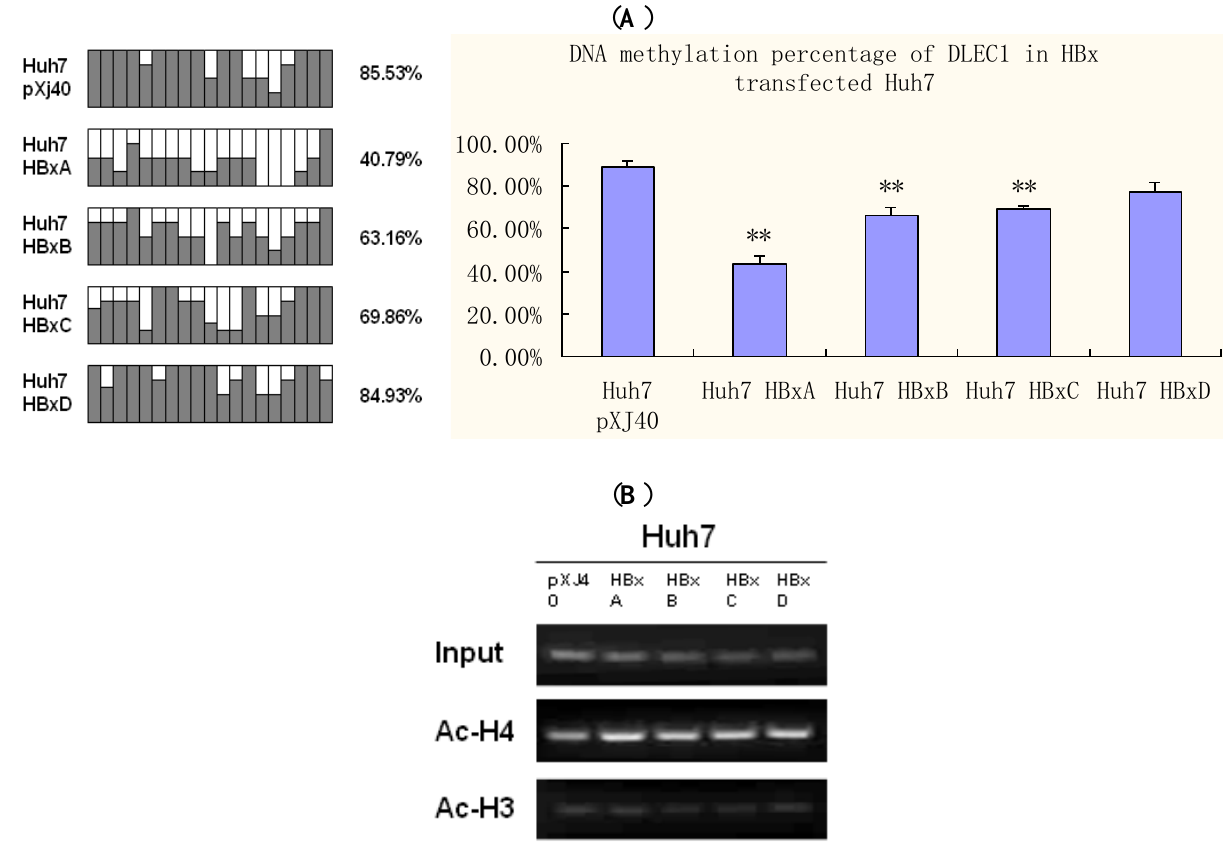
Figure 5. DNA methylation and histone acetylation status of DLEC1 in Huh7 expressing HBx genotypes A-D. (A) Promoter methylation analysis by bisulfite genome sequencing of DLEC1 5’ CpG sites in Huh7 transfected by HBx genotypes A-D. Open area indicates the percentage of unmethylated CpG sites, while dark area indicates percentage of methylated CpG sites. The quantitative result in percentage of methylated CpG sites is listed on the right of the column groups. Three independent experiments were carried out and representative result from one of them was listed here as the upper panel; the lower panel summarized the results from all three experiments. (B) ChIP analysis of the 5’ region of DLEC1 in Huh7 expressing HBx. Input indicates 1% of total DNA prior to immunoprecipitation. pXJ40 was included as an empty vector control. Experiments